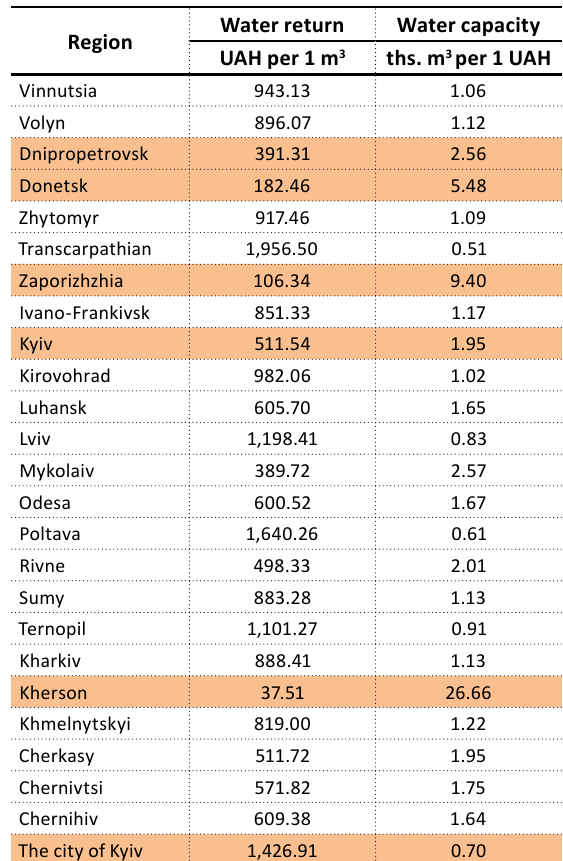
Table 3. Water capacity and water return of GRP in